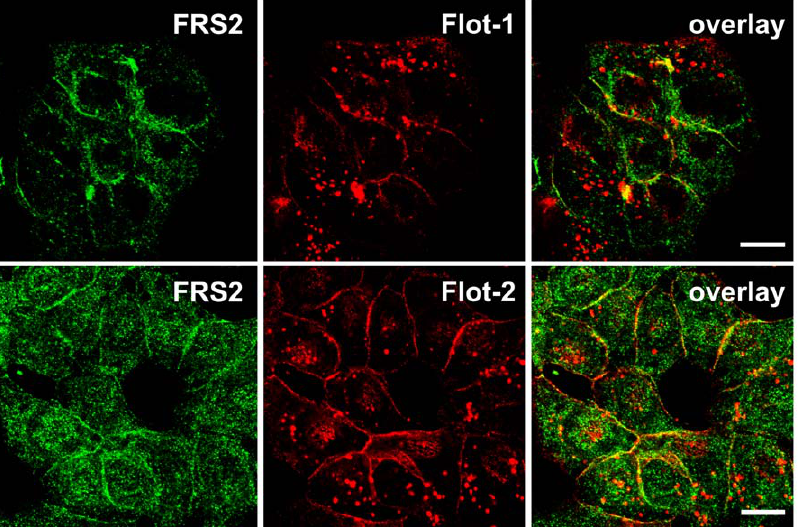
Figure 2. Endogenous flot-1 and flot-2 colocalize with FRS2 in Hep3B cells. Cells were grown in a medium containing FCS and stained with antibodies against endogenous FRS2 (green) and flot-1 or flot-2 (red). Scale bars 10 m m.